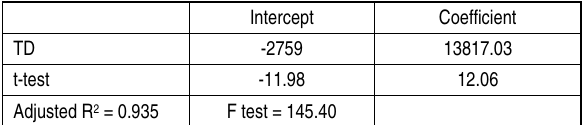
Table 6. Temporary Dispersion (TD) for Climate